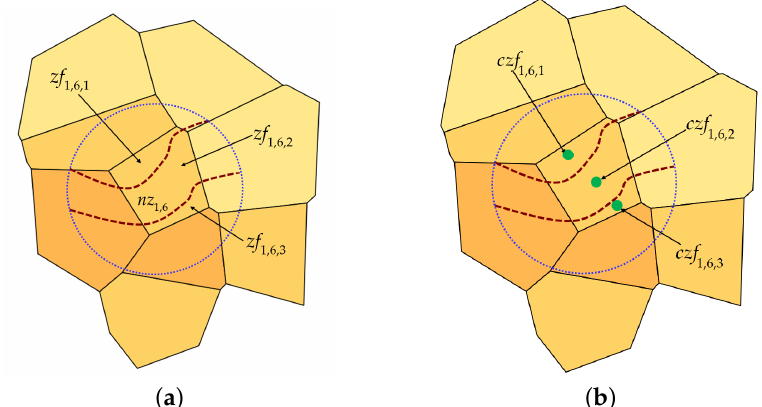
Figure 4. The zone fragments ( zf 1,6, t ) of the nearest zone nz 1,6 ( a ), and their centroids ( czf 1,6, t ) ( b ); t =